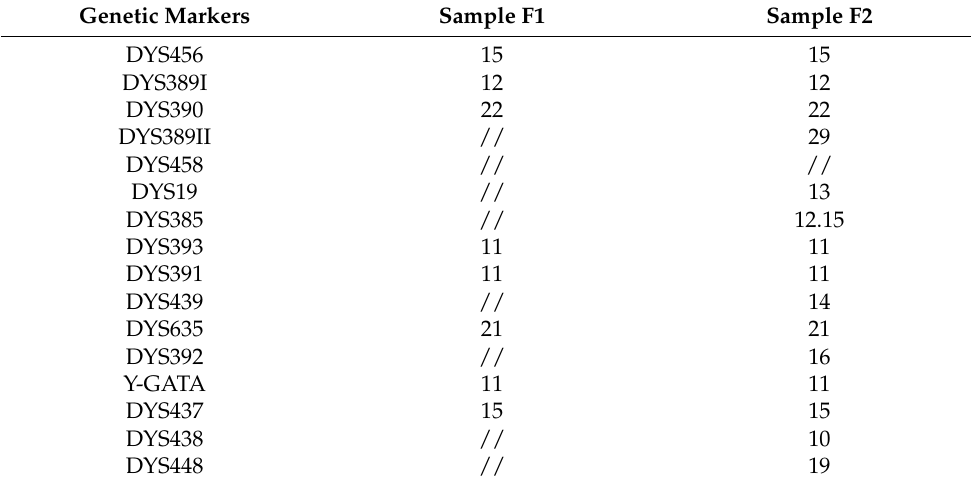
Table 5. Y chromosome genetic marker results. Genetic